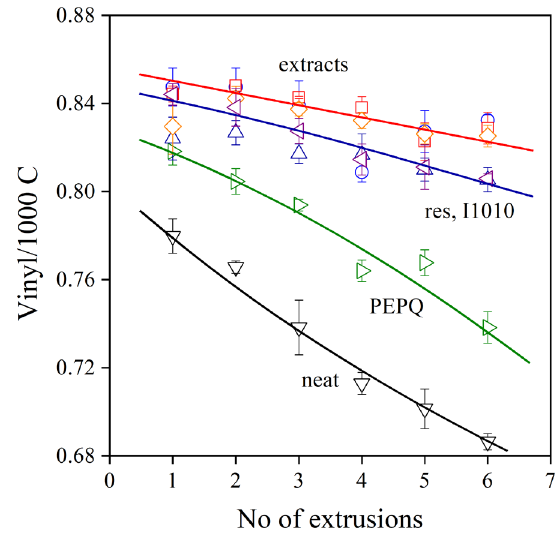
Figure 6. Vinyl group content of polyethylene containing various additive packages plotted against the number of extrusion steps. Symbols: ( ) neat polymer, ( ) PEPQ, ( ) I1010, ( ) resveratrol, ( ) StirExt, ( ) SoxExt and ( ) UsoundExt. Additive content: 1000 ppm PEPQ was added to packages containing 1000 ppm phenolic antioxidants.